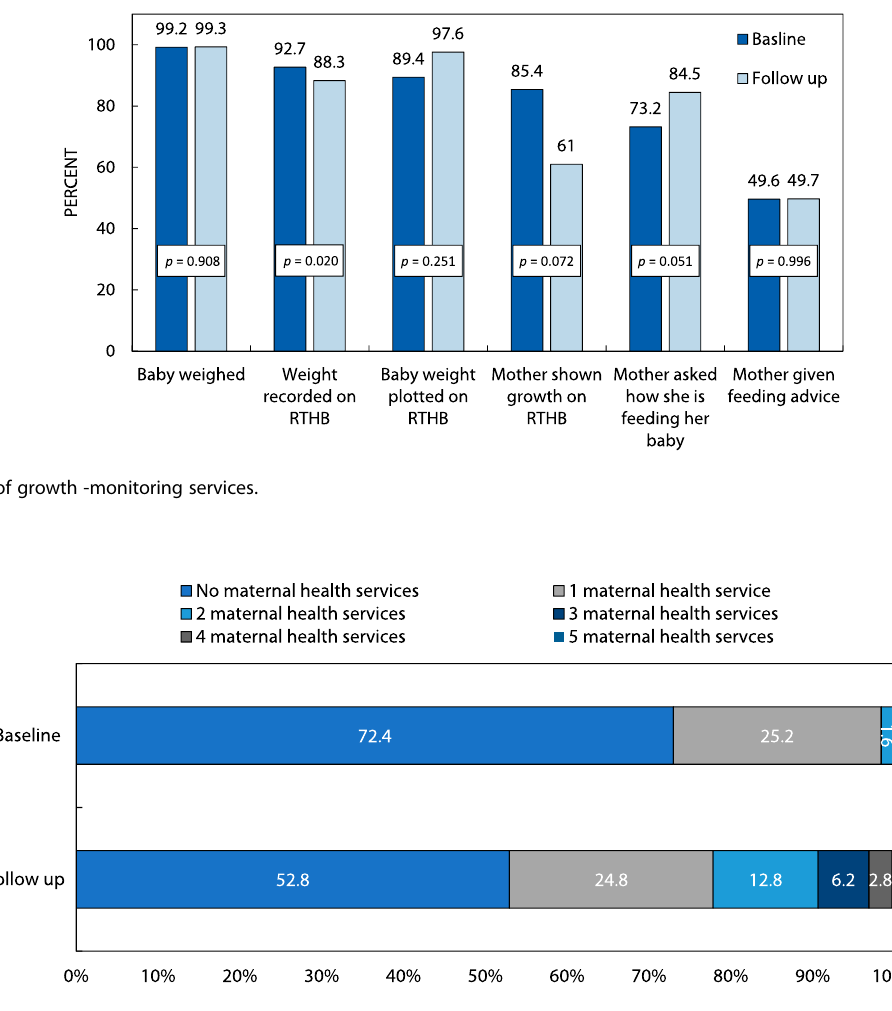
Figure 3: Number of maternal health services received on well-child